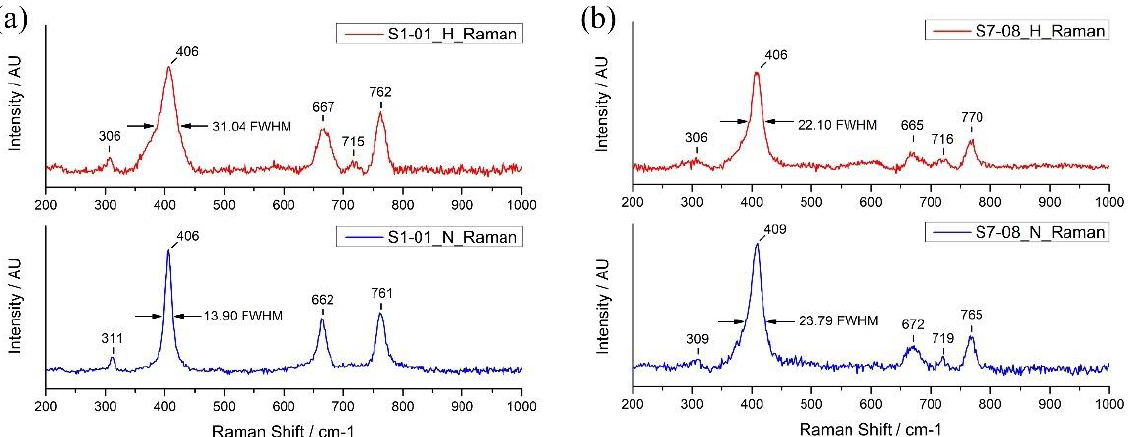
Figure 3. Representative Raman spectra of ( a ) red spinel as a common pattern of most sample groups and ( b ) green spinel presenting dissimilarly pattern to the other groups both before (blue lines, lower spectra) and after (red lines, upper spectra) heating experiment .